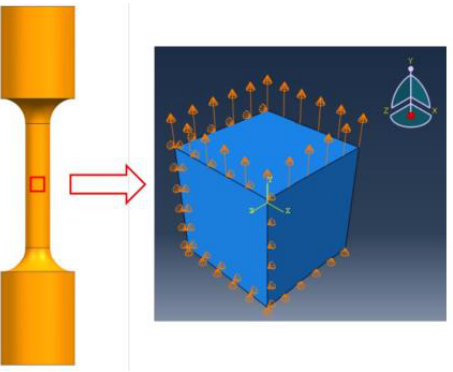
Figure 4. Element model and boundary condition. Table 3. Fitting values of elastic and kinematic hardening